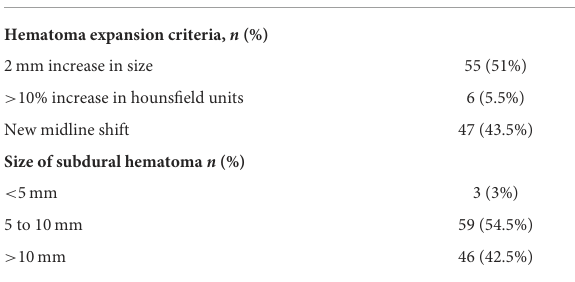
TABLE 1 Hematoma expansion criteria and size of subdural hematoma on repeat CT head.